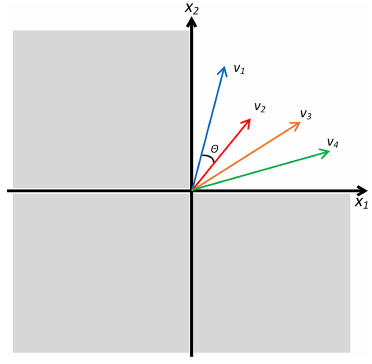
Figure 10. An illustration of shrinking embedding